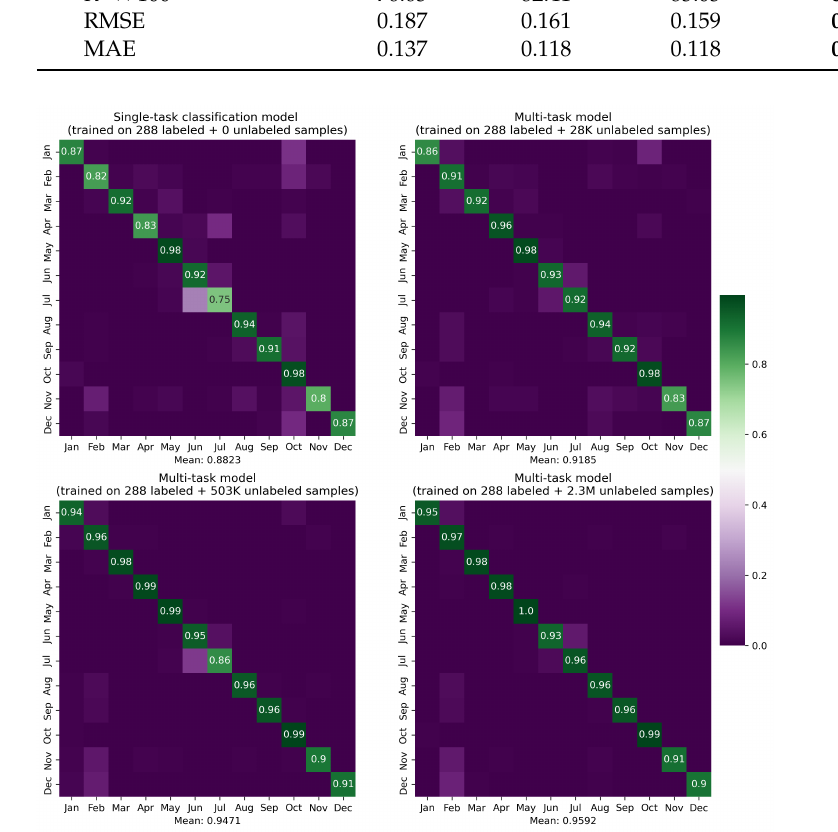
Figure 5. The confusion matrices devoted to the prediction of months.